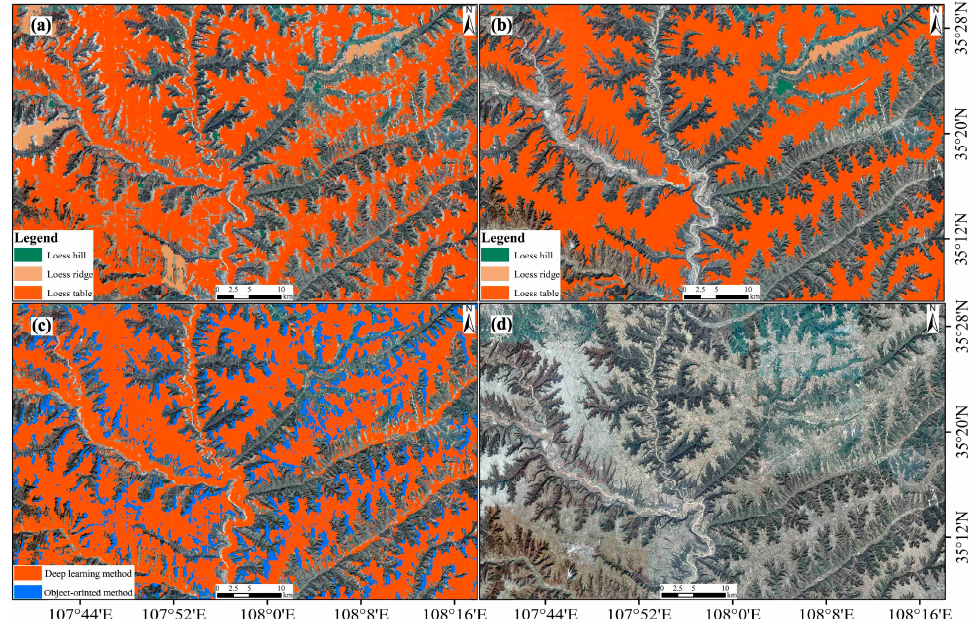
Figure 9. Comparison of results between DL and OBIA method. ( a ) Classification result of DL method; ( b ) classification result of OBIA method; ( c ) superposition of the results of the two methods; ( d ) original remote